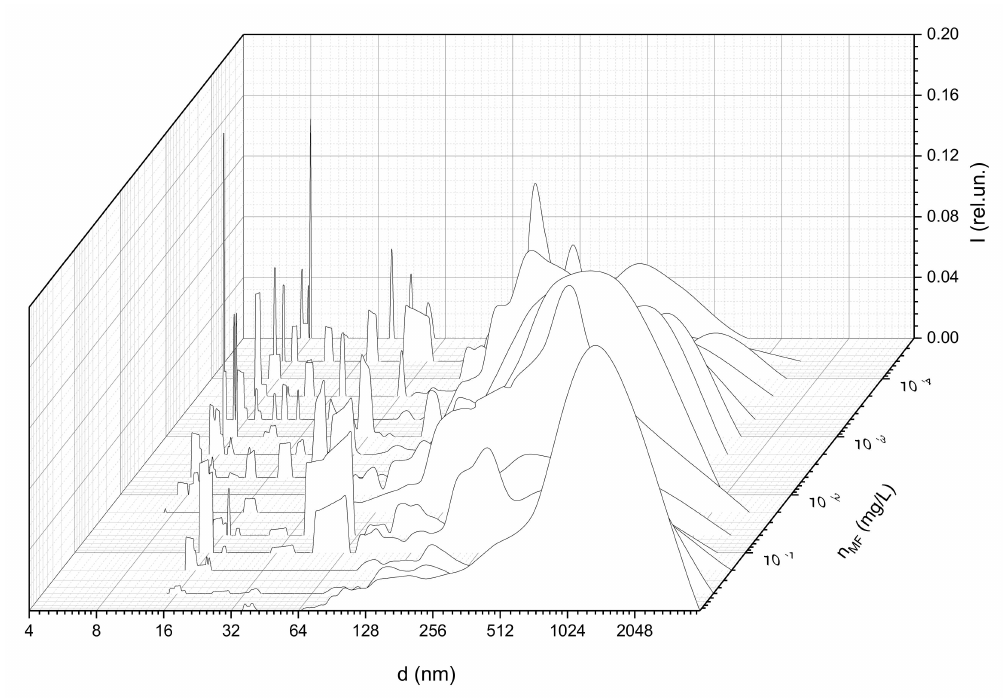
Figure 3. Size distribution of structures in albumin solutions with the addition of magnetic fluid at various concentrations. At low MF concentrations in the solution, individual particles with sizes of about 6 nm,